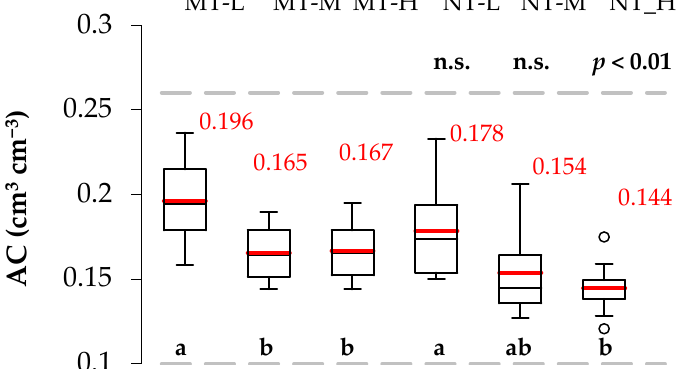
Figure 6. Box plots of air capacity ( AC ). Interval between the dashed lines represents the optimal values of AC according to Castellini et al. [22]. For a given soil management practice, mean values of water height followed by the same letter are not statistically different according to a Tukey HSD test; for a given water height, differences in soil management were reported according to a two-tailed t -test (n.s. = not significant). For the meaning of the abbreviations or interpret box plots, please refer to the caption of Figure 5.